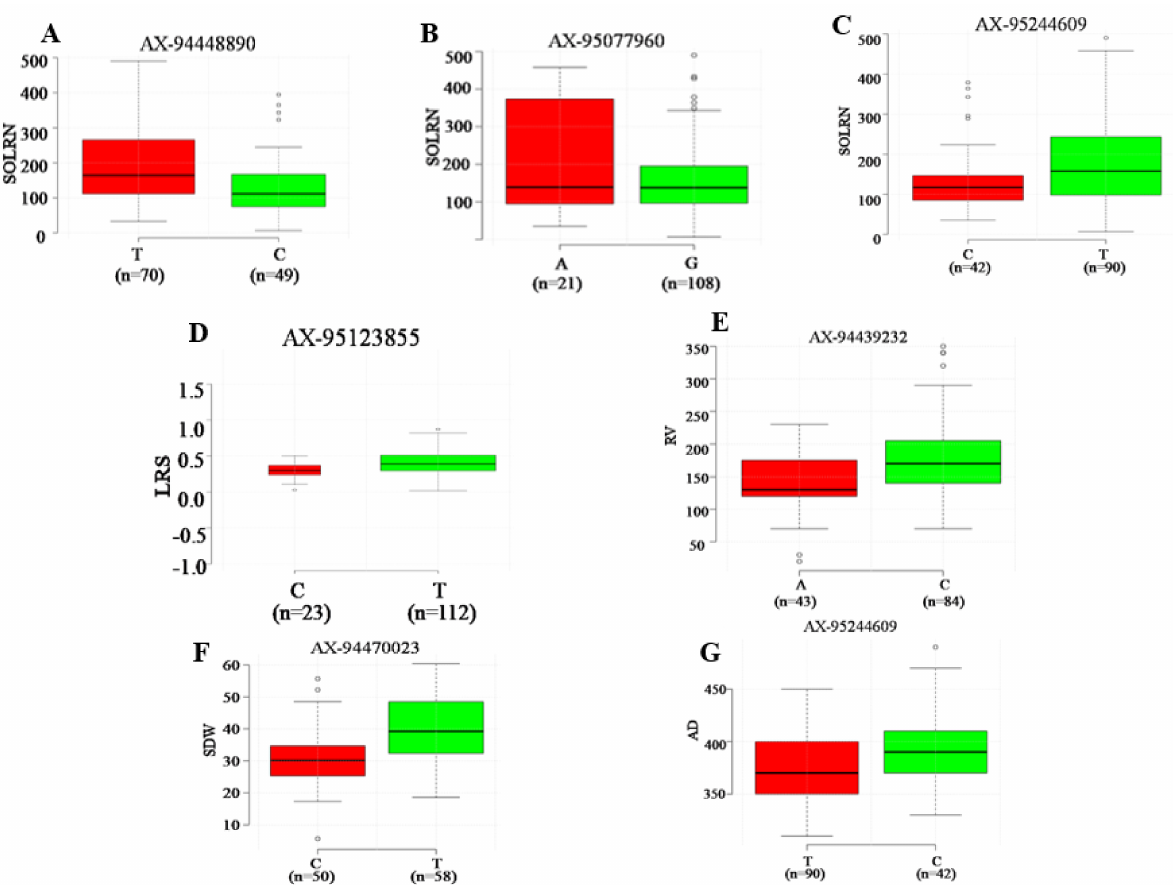
Figure 5. Boxplot for seven reliable QTNs with significant effects ( p < 0.01) on corresponding root and shoot traits. For each QTNs, the germplasm lines were divided into two groups according to superior and inferior allele type. The x -axis represents the two alleles for each QTNs, while the y -axis corresponds to phenotypic value. Subfigures, ( A – C ) represent allelic differences for SOLRN and superior alleles for QTNs Q.SOLRN-1DS, Q.SOLRN-1BL and Q.SOLRN-6AL were T, A and T respectively. Subfigures ( D – G ) represent allelic differences for LRS, RV, SDW and AD for QTNs Q.LRS-7BS, Q.RV-5BL, Q.SDW-4AL and Q.AD-6AL with superor alleles as T, C, T and C